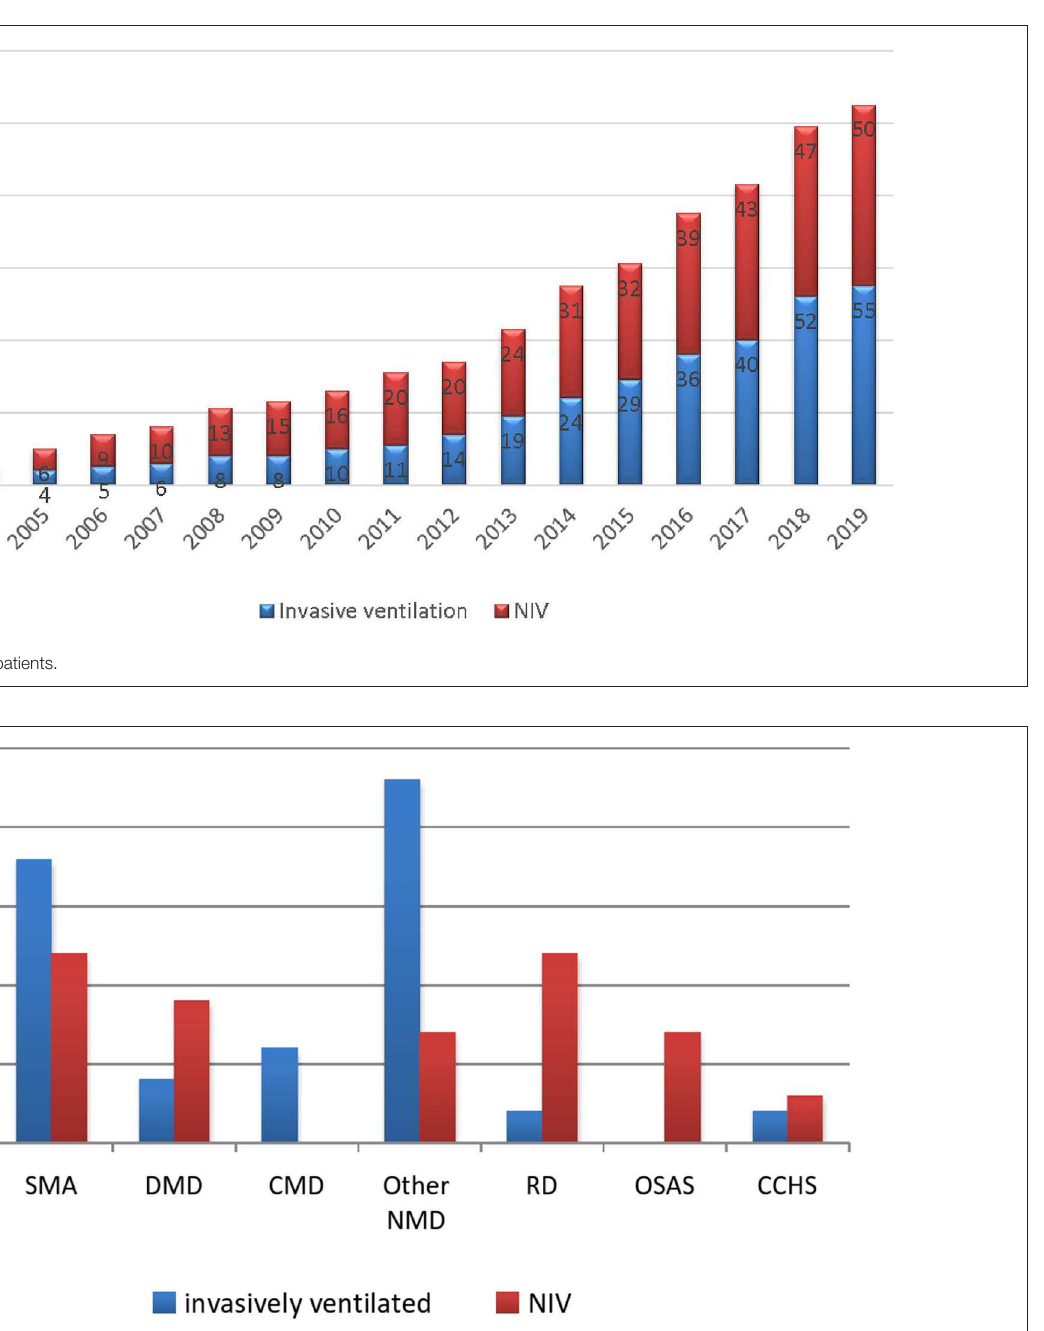
different masks was allowed on patient’s demand in order to improve both compliance and comfort, as well as to prevent facial deformities. Unfortunately, mouthpiece ventilation has not been available for our